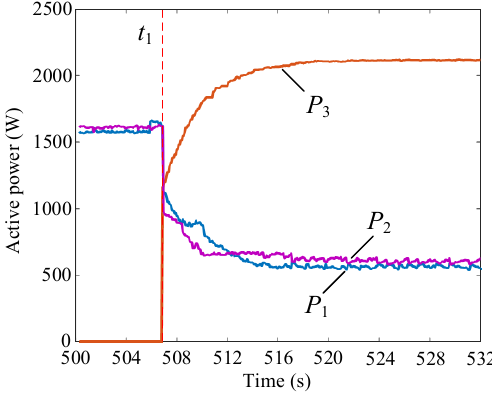
Figure 9. Active power waveforms of microgrid at Case 1.